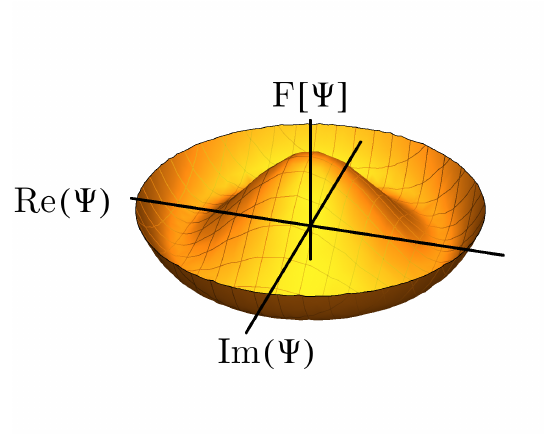
Figure 5.4: Plot of the “Mexican hat” free energy in Eq. (5.6) for r <